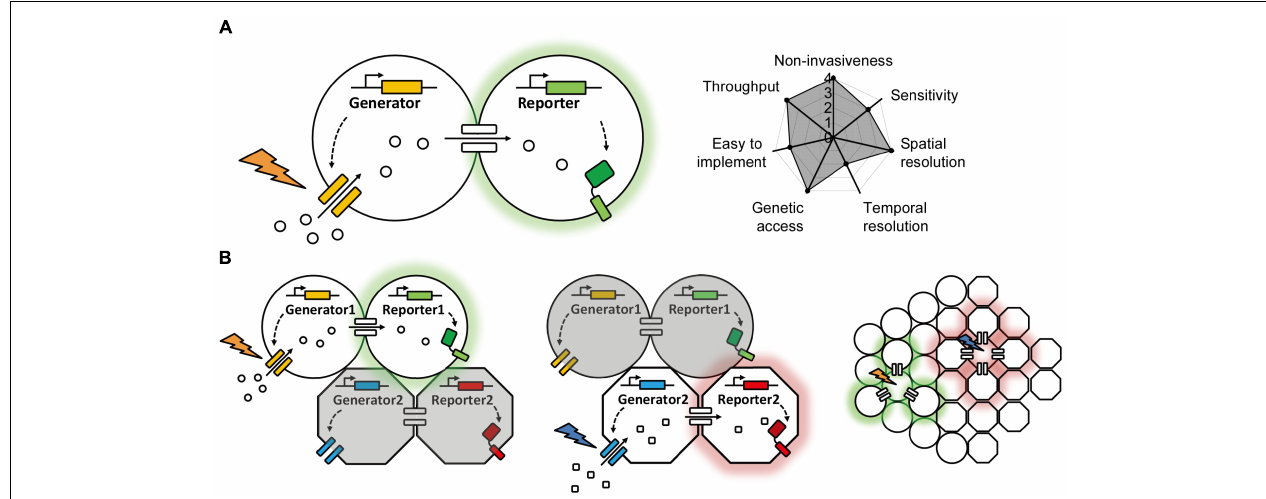
FIGURE 2 | A proposed ideal optogenetics-based system for mapping gap junctions. (A) The principle behind the proposed optogenetics-based system shown on the left with its theoretical performance index on the right, similar to Figure 1 . (B) A proposed multiplex, optogenetic system for mapping gap junction using two pairs of bio-orthogonal generators and reporters and its application in an intact tissue with heterogeneous cell types.